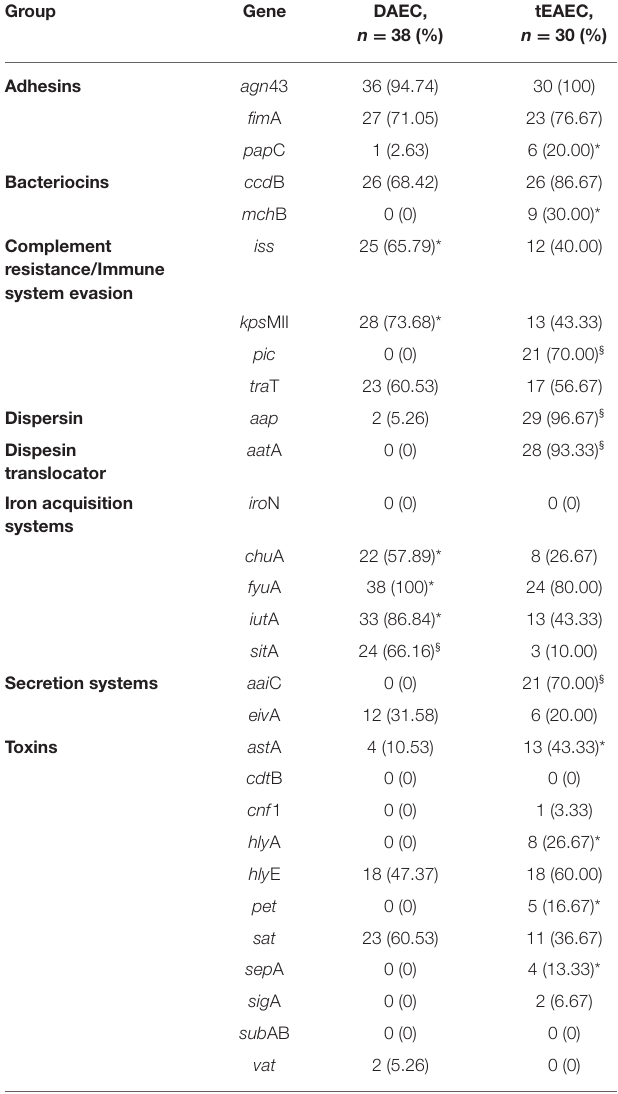
TABLE 4 | Prevalence of 29 selected virulence genes among DAEC and tEAEC strains identified as the only pathogens isolated from children with diarrhea. Group Gene DAEC, n = 38